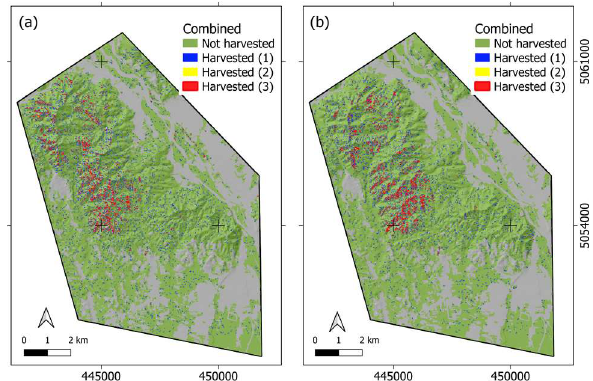
Figure 8 . Forest harvestings classification by combined method for (a) ascending CRTS and (b) for descending CRTS. Colours represent how many times a pixel was classified as Harvested by combining all methods. Reference frame is WGS84 UTM 32N.